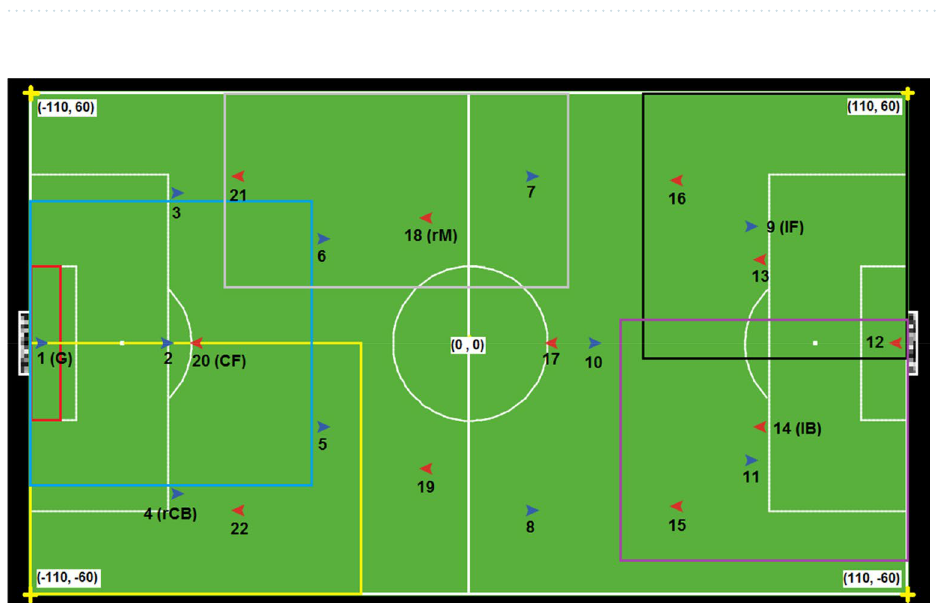
Figure 3. Six examples of the assumed spatial restrictions (role-boxes) for agents. The measurements are relative to a Cartesian coordinate system with the origin point at the middle of the pitch (from 46 ). Team A and Team B are represented in blue and red,